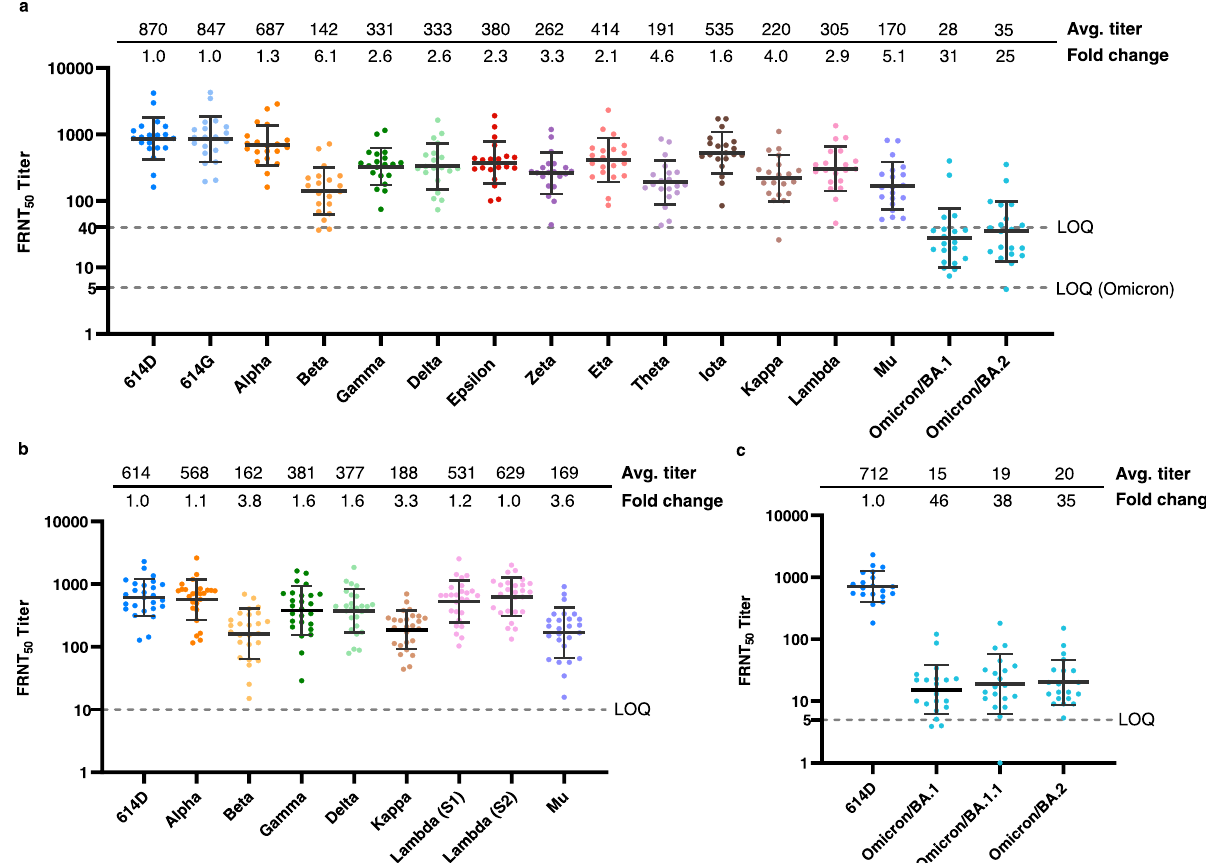
Fig. 2 Neutralizing activity of mRNA vaccinee sera (post-second dose) against live SARS-CoV-2 viruses. Each dot represents the neutralizing titer (FRNT 50 ) of an individual serum sample against a speci fi c SARS-CoV-2 virus, which is labeled on the X -axis. Different colors represent the progenitor virus or different variants (speci fi c mutations provided in Supplementary Table 1). Vaccinee serum samples were obtained from people who were vaccinated 2 – 6 weeks post second dose. The geometric mean FRNT 50 titers are represented in the graph as bars on top of the dots with geometric standard deviation. The geometric mean FRNT 50 titers (avg. titer) and average fold changes relative to reference virus 614D (set as 1-fold) are shown on the top of the graph. For each variant, the average fold change is the geometric mean of the individual FRNT 50 ratios (614D/variant) calculated for each serum sample. Dashed line represents the limit of quantitation (LOQ). For statistical analysis, a two-tailed Wilcoxon matched-pairs signed-rank test was performed by comparing each variant with 614D. Test statistics and P value are summarized in Supplementary Table 2. Source data are provided as a Source Data fi le. a Representative reporter viruses of all past and current WHO designated SARS-CoV-2 VOCs and VOIs were tested. N = 20 biologically independent sera examined over 16 viruses. LOQ = 5 for Omicron and LOQ = 40 for all other viruses. The average fold changes of all viruses differ signi fi cantly ( P < 0.0001) from 614D, except for 614G ( P = 0.8124). b VOCs and selected VOIs isolated from clinical specimens were tested. N = 26 biologically independent sera examined over 9 viruses. The average fold changes of all viruses differ signi fi cantly ( P < 0.0001) from 614D, except for Alpha ( P = 0.4833) and the two Lambda viruses (Lambda S1 and S2, P = 0.0796 and 0.7265, respectively). c Omicron subvariant BA.1, BA.1.1, and BA.2 isolated from clinical specimens were tested. N = 20 biologically independent sera examined over four viruses. The average fold changes of all viruses differ signi fi cantly ( P < 0.0001) from